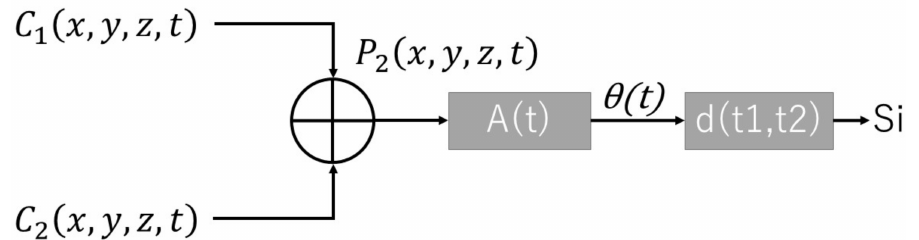
Figure 9. Process of combining data, calculation of the agent peak hand position times into the subject agent phase (Formula (3)) and calculating the difference between the average of phases (Formula (4)). The difference between the average of the phases in the first half and the latter half was the synchronization index.